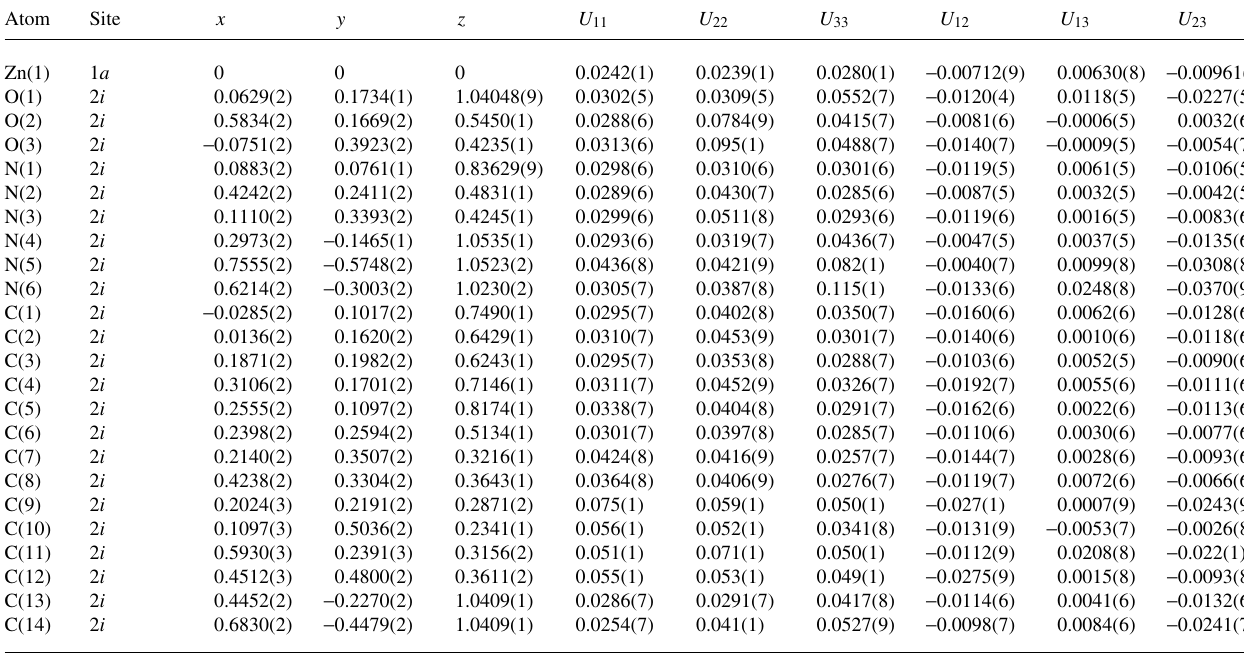
Table 3. Atomic coordinates and displacement parameters (in Å 2 ) .